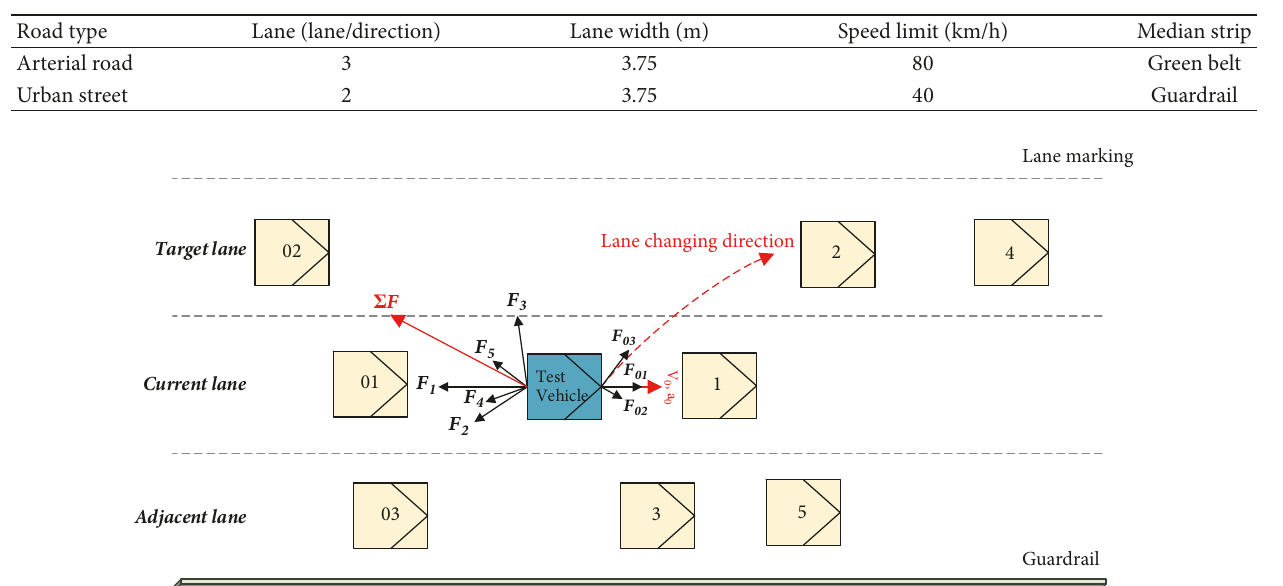
Table 1: Test route illustration.